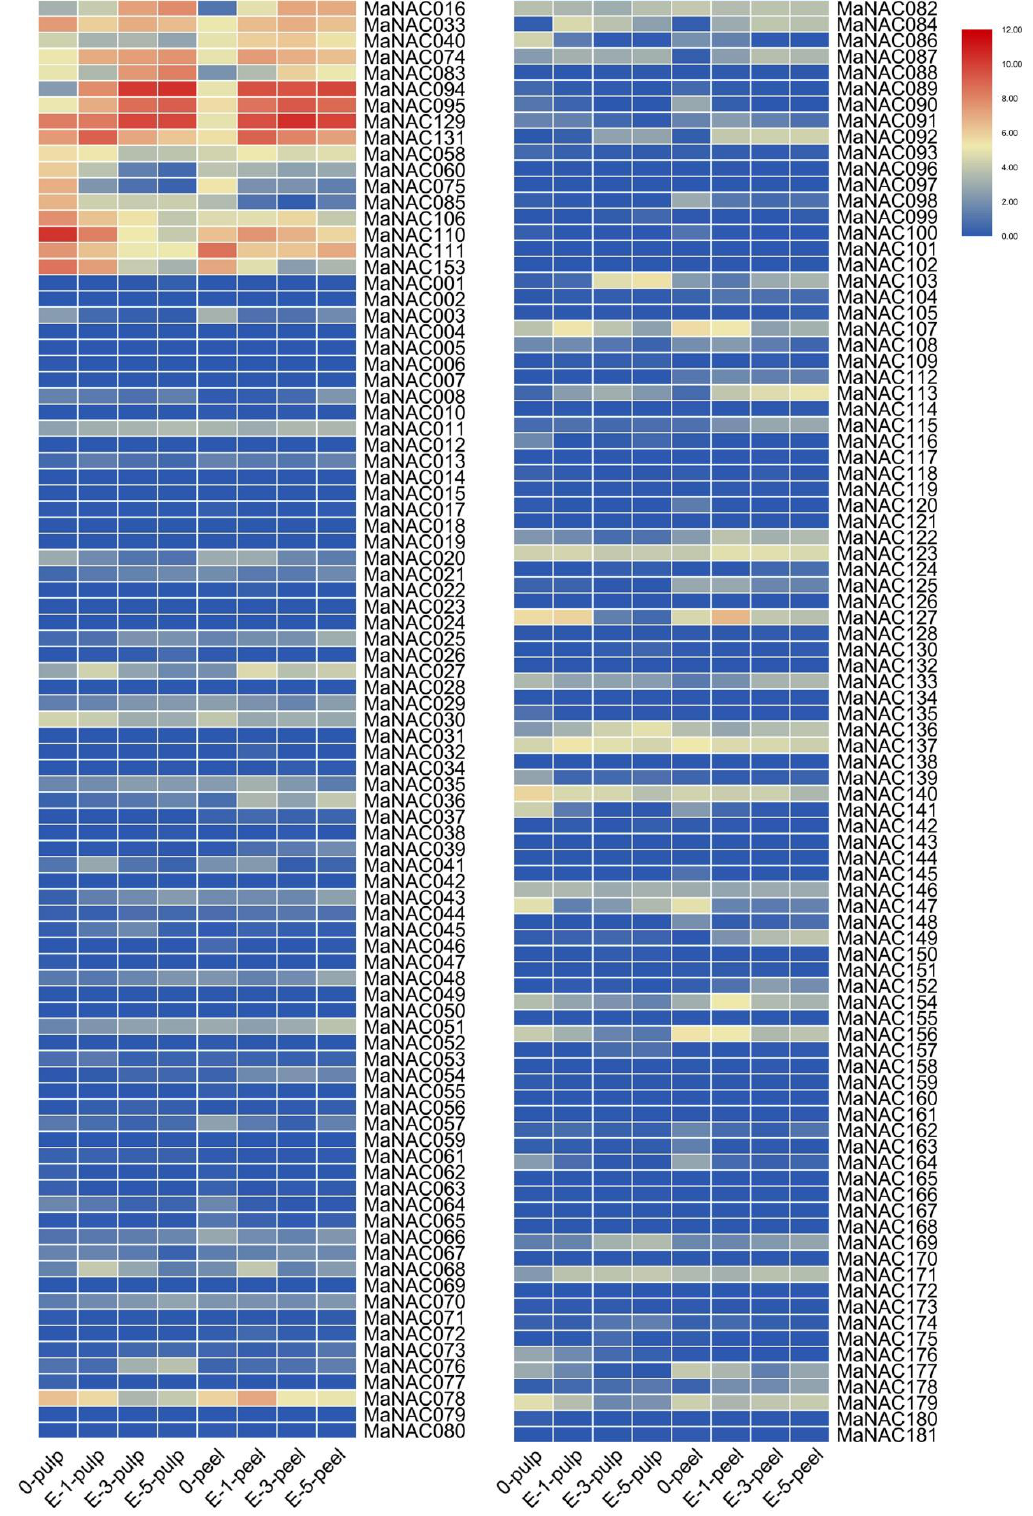
Figure 5. Expression patterns of MaNAC genes in the pulp or peel of banana at different intervals after treatment with ethylene (E represents ethylene, the number indicates the days after treatment). The heat map was generated using TBtools. The bar at the right of the heat map represents relative expression values.